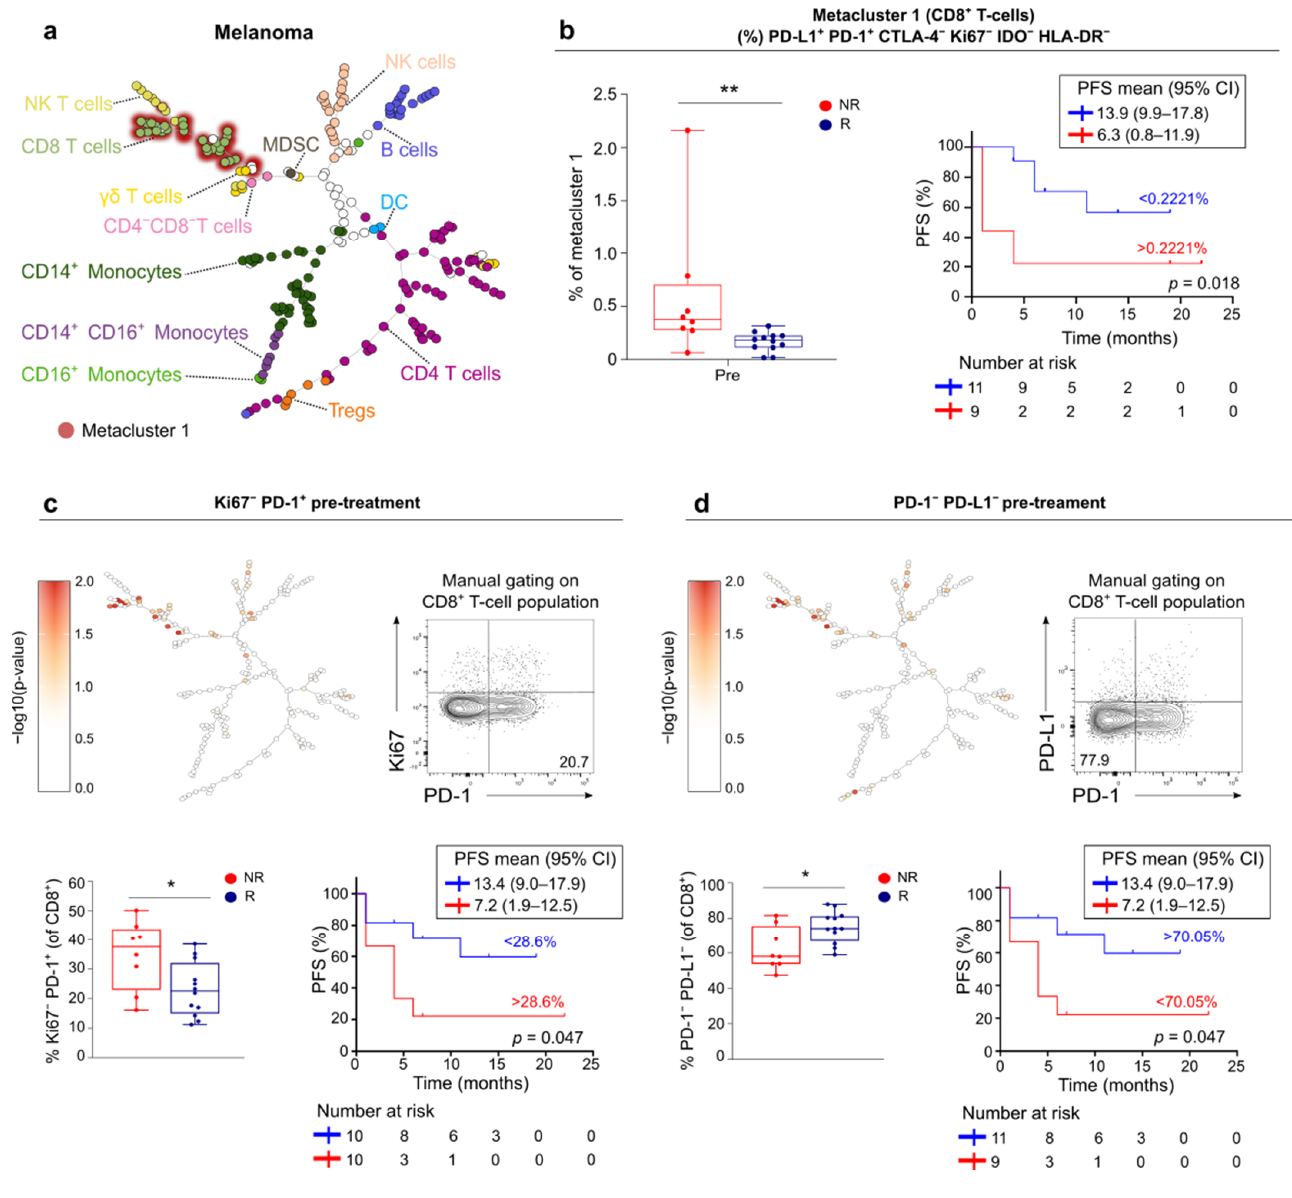
Figure 4. Pre-treatment expression of PD-1 and PD-L1 in non-proliferating CD8 + T-cells correlates with non-response to anti-PD-1 in melanoma. ( a ) FlowSOM tree of concatenated flow cytometry data of PBMCs from 20 melanoma patients (85 samples). ( b ) (left) Boxplot of the pre-treatment expression of indicated signature in metacluster 1 (CD8 + T-cells) in non- responders (NR) and responders (R). p value calculated using two-sided Mann-Whitney U test. ** p < 0.01. (right) Kaplan- Maier estimate of PFS stratified according to low (<0.2221%) or high (>0.2221%) expression of PD-L1 + PD-1 + CTLA-4 − Ki67 − IDO − HLA-DR - in metacluster 1. p value calculated using log-rank test. ( c , d ) (top left) Melanoma FlowSOM tree depicting differences in expression of the indicated signature in clusters between non-responders and responders at pre-treatment. −log10( p values) are plotted on FlowSOM tree showing the significantly over- or underrepresented clusters in non-re- sponders versus responders. (top right) Contour plot ( n = 10) representing manual gating strategy on total CD8 + T-cell population to confirm FlowSOM signature. (below left) Boxplots with expression of manually gated signature in non- responders (NR) and responders (R), p value in boxplots calculated using two-sided Mann-Whitney U test. * 0.01 < p < 0.05. (below right) Kaplan-Maier estimate of PFS stratified according to low or high expression of indicated signature. p value calculated using log-rank test. ( b – d ). Whiskers of boxplots extend to the minimum and maximum data point, with the horizontal line indicating the median.